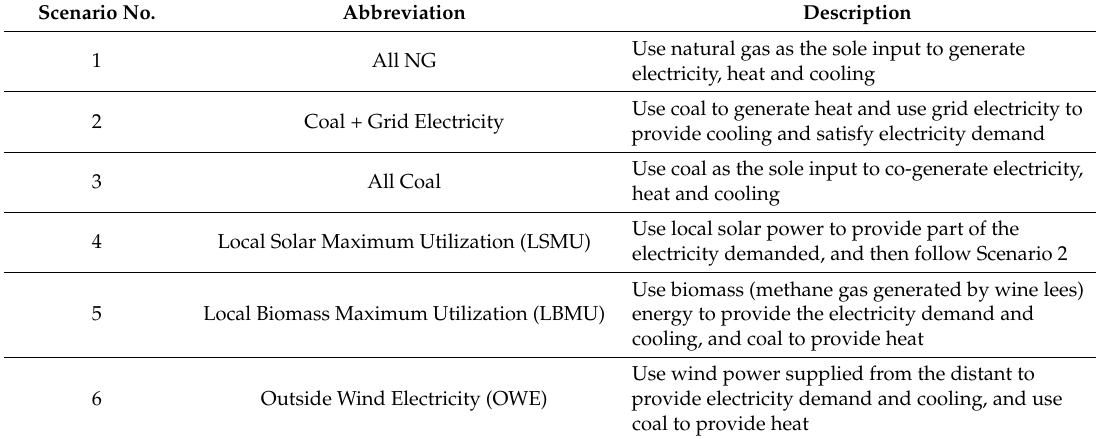
Table 2. Description of the scenarios designed and implemented in this